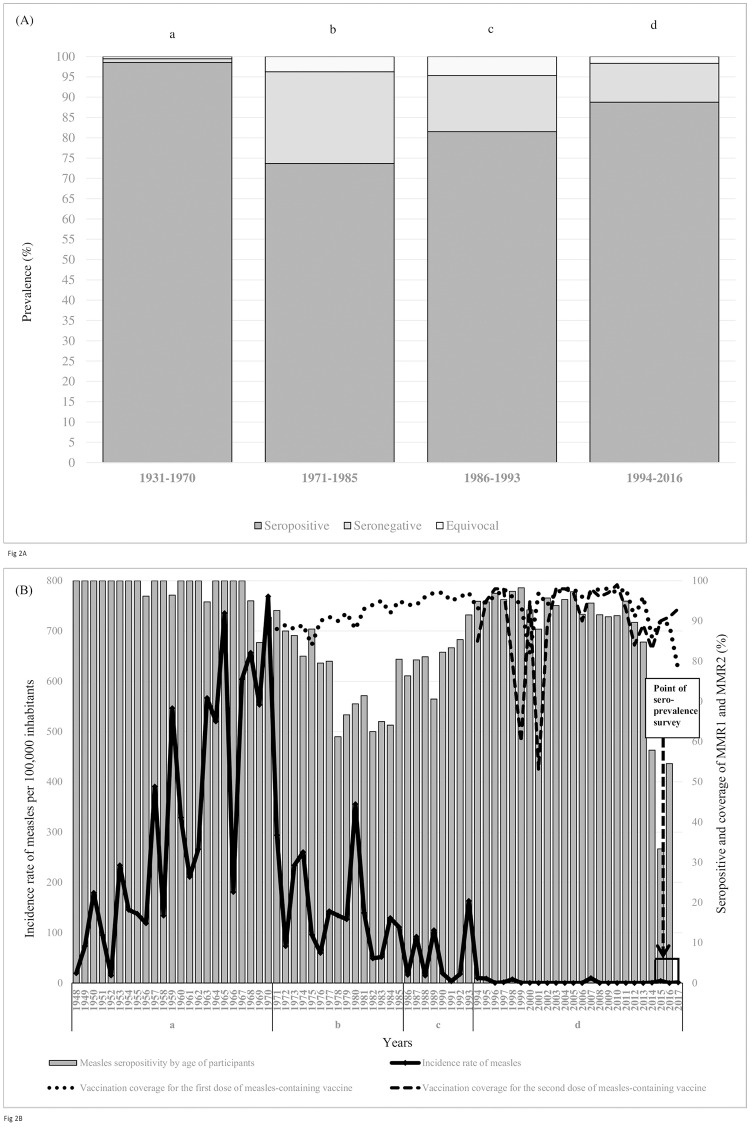
Seroprevalence of measles antibody in four birth cohorts (A), and measles incidence, measles seropositivity and MMR vaccine coverage rates (B) in Vojvodina, Serbia. a-vaccine-free period; b-single measles monovaccine period; c-single combined measles-mumps vaccine period; d-two doses combined measles-mumps-rubella vaccine period.(B) x-axis represents actual years for measles notification per 100,000 inhabitants, measles seropositivity by age considering the point prevalence of the study (time of sampling 2015–2017), and annual immunization coverage of the first and the second dose of measles vaccine for those born one year earlier than the year on x-axis.